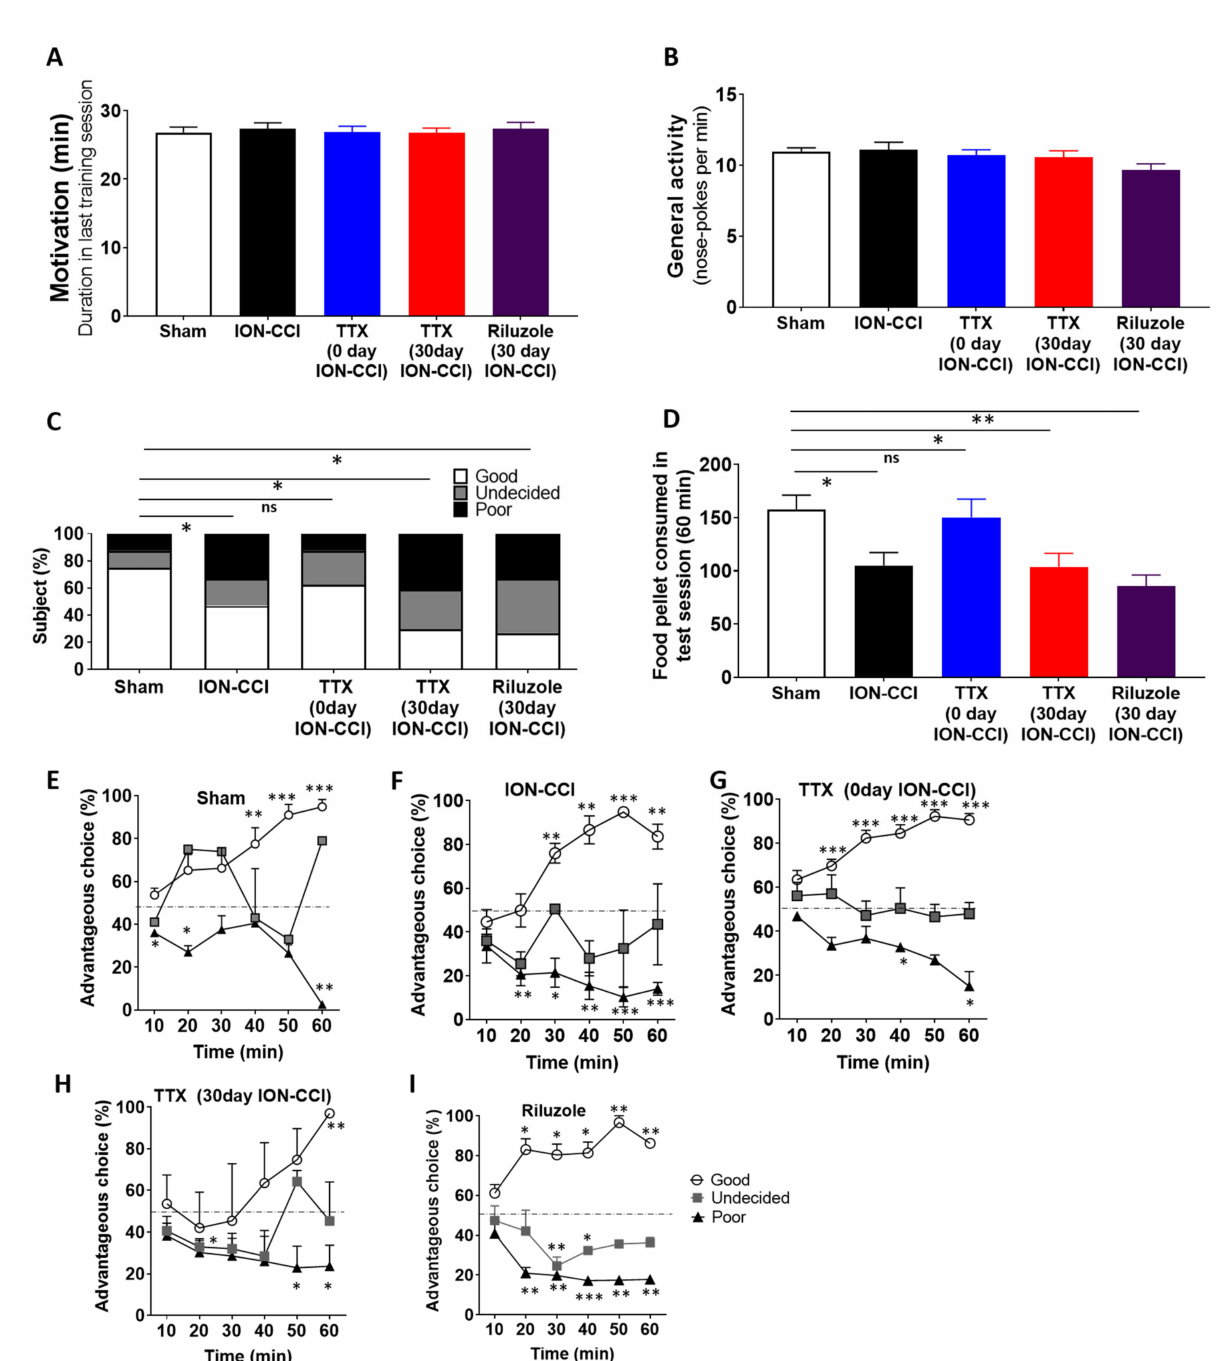
Figure 2. Assessment of decision-making behavior in ION-CCI rats with various pharmacological interference. ( A ) Motiva- tion is measured as the duration taken to consume 100 food pellets during the last T2 training session. Motivation level is maintained at an optimum level for each rat before RGT task. All the rats were equally motivated for the task, and there was no significant difference in the motivation levels between the five groups. ( B ) General activity measured as the